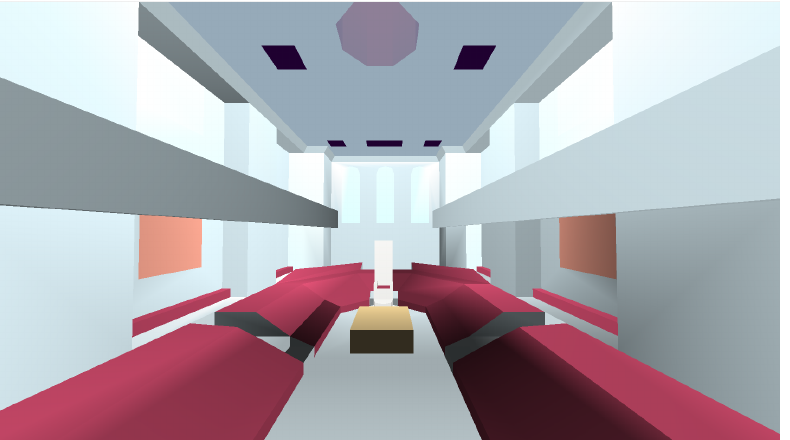
Figure 7. A virtualisation of the final model in ODEON with the simplified representation of the seating